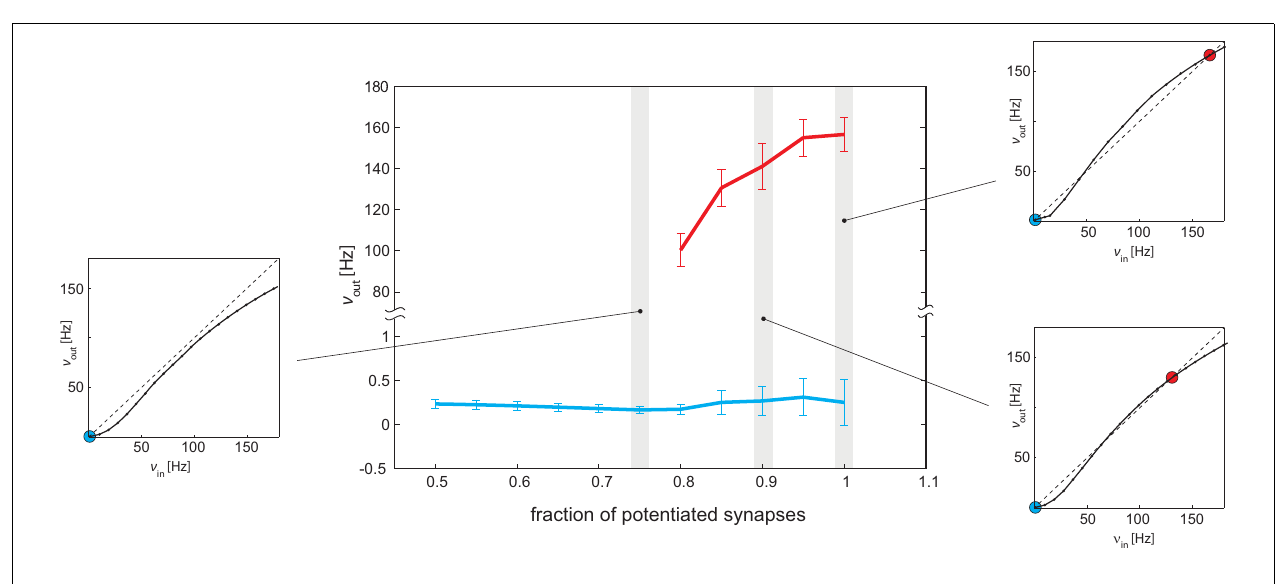
analysis of effective response functions (ERFs, insets on either side) measured on-chip. For weak recurrency of f = 0.75, the ERF predicts a “low” meta-stable state (blue dot, left inset), for intermediate recurrency of f = 0.9, it predicts a “low” and a “high” state (blue and red dots, bottom right inset), and for high recurrency of f = 1, it predicts that “low” and “high” states are separated more widely (blue and red dots, top right